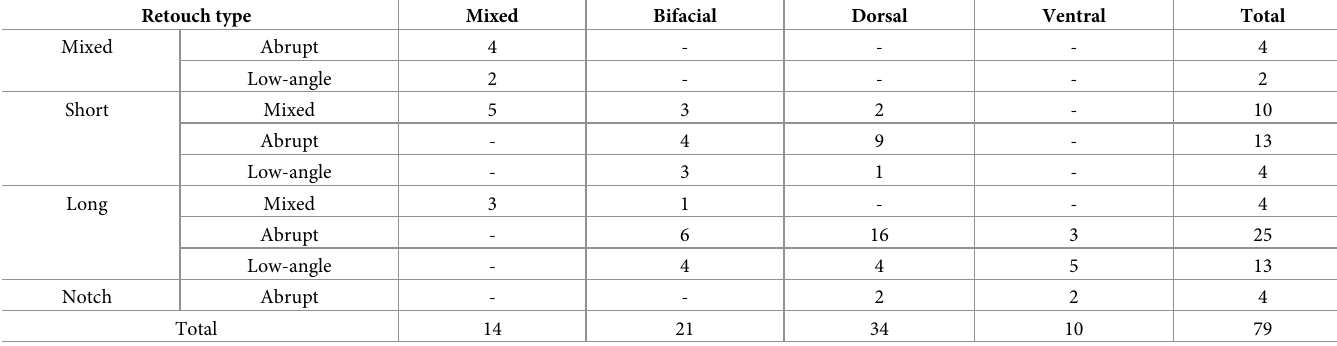
Table 5. Distribution of retouch types (location, extent and orientation) at Dungo